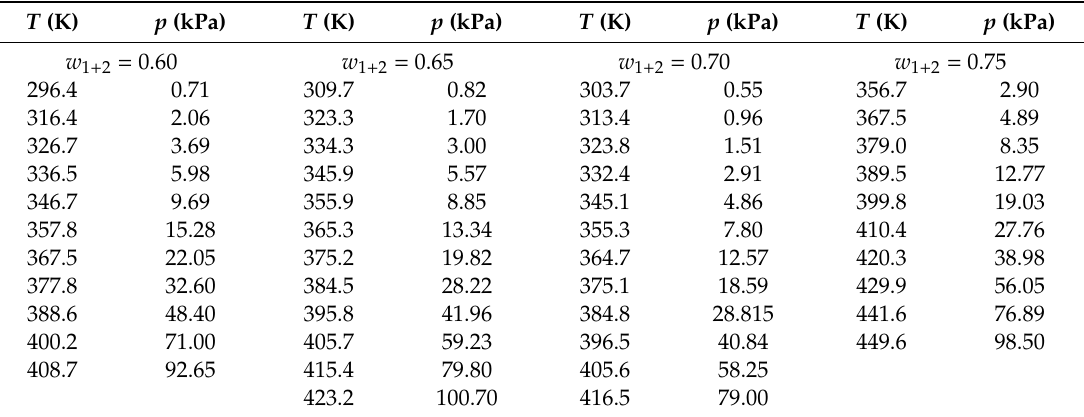
Table A1. Saturated vapor pressure at absorbent mass fraction w of the system LiBr (1) + [BMIM]Cl (2) + H 2 O (3) at p = 0.1